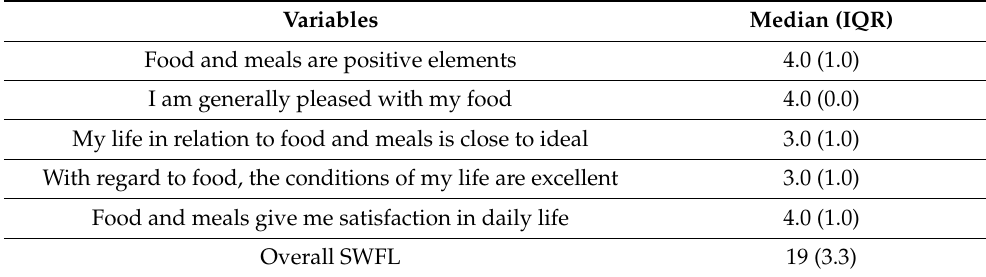
Table 3. Median score of five items of the Satisfaction with Food Life (SWFL) scale .